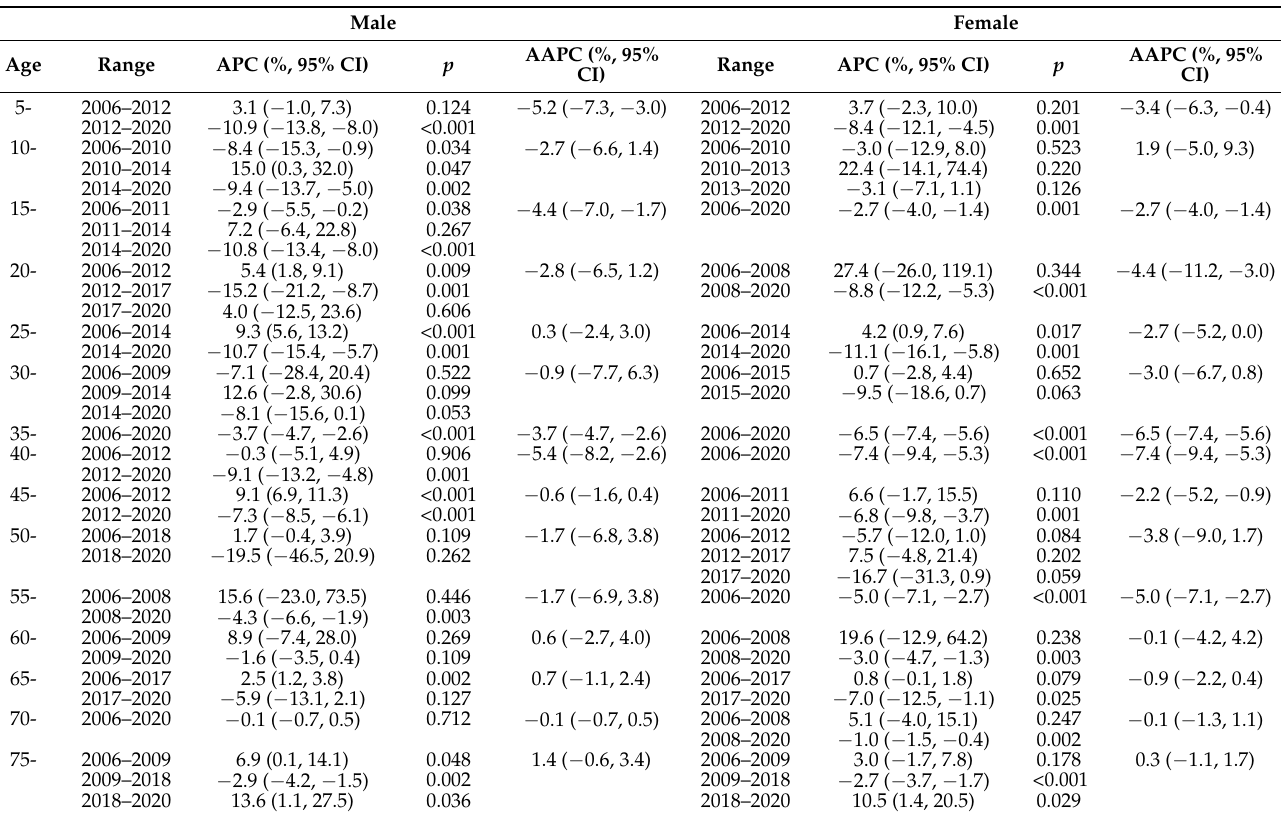
Table A2. The temporal trends in age-specific mortality rates for each age group in rural regions using Joinpoint regression analysis.